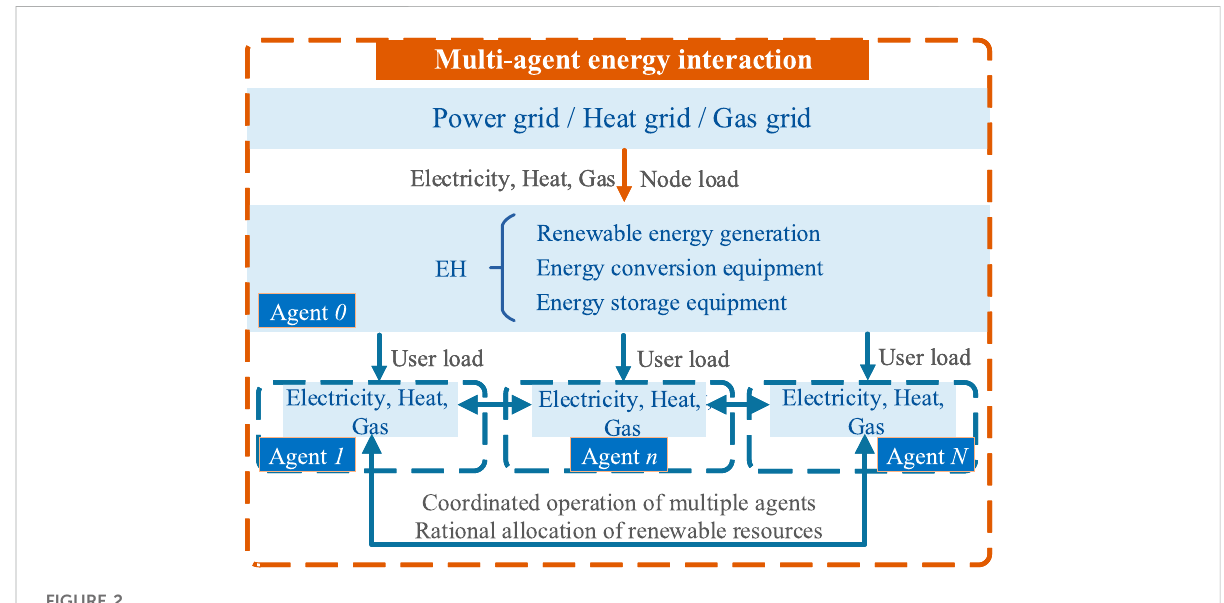
FIGURE 2 The multi-agent decentralized optimization